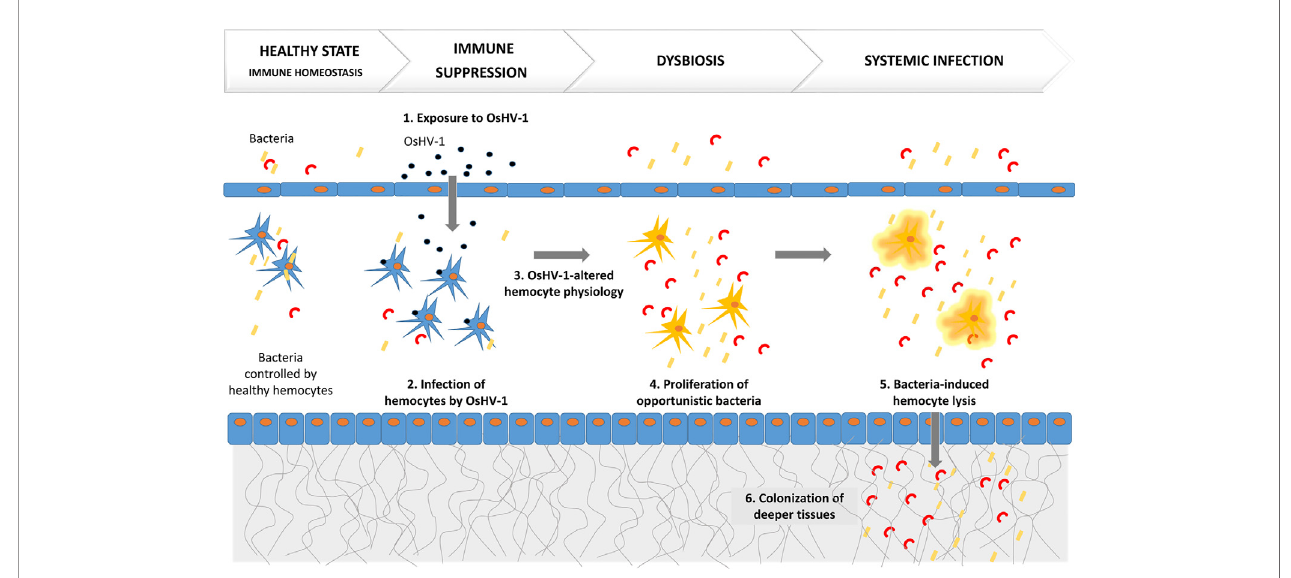
FIGURE 1 | POMS is a polymicrobial disease induced by a primary infection by OsHV-1, which alters hemocyte physiology. This is followed by secondary bacteremia that leads to oyster